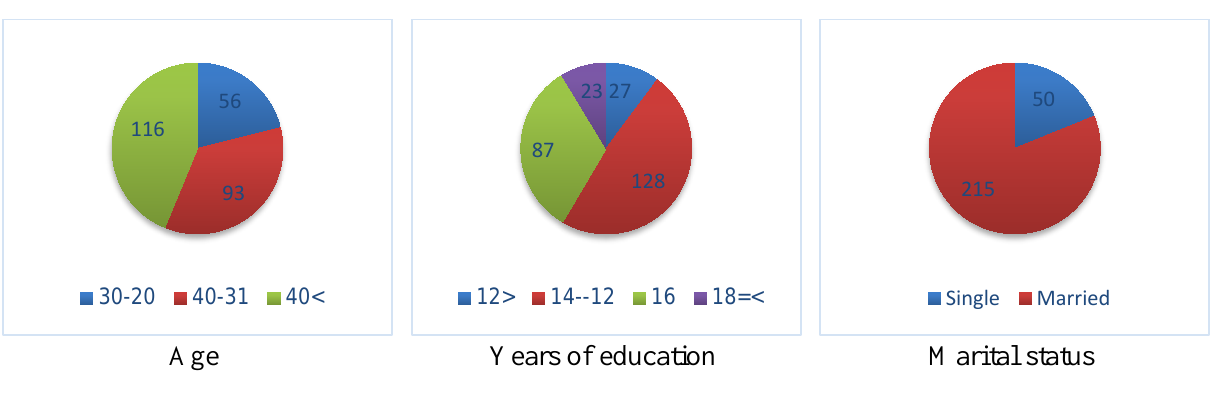
Fig. 1. Personal characteristics of the